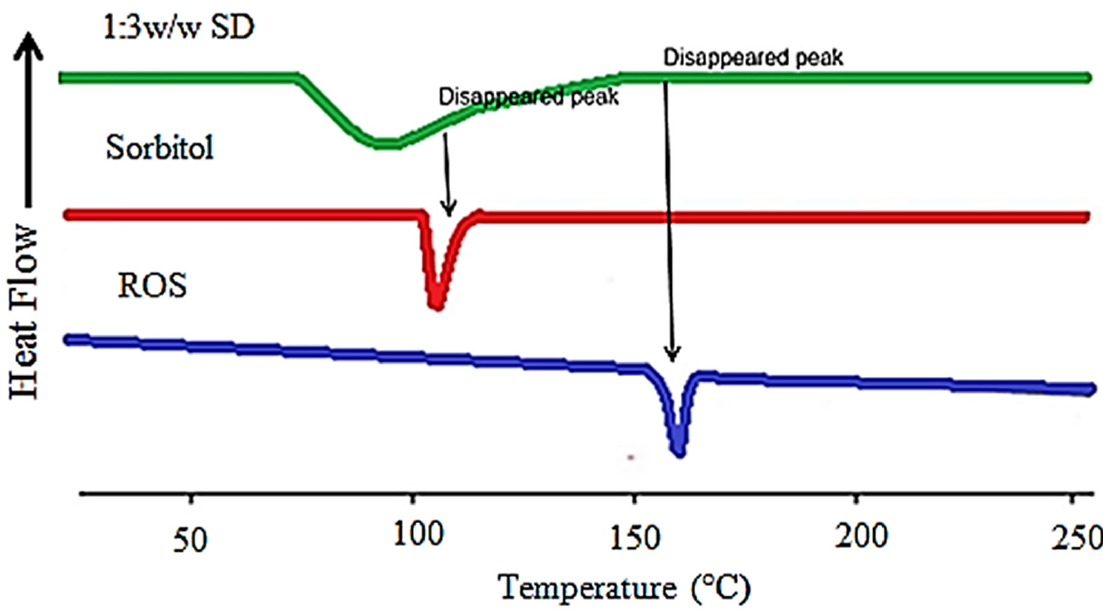
Figure 3. DSC curves of pure ROS, sorbitol, and ROS-SDs (1:3 w / w SD).